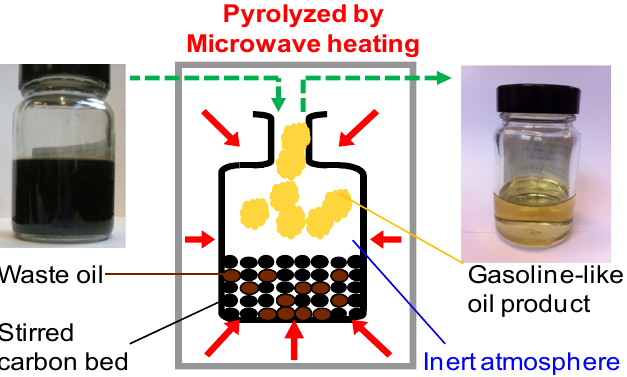
Figure 3. Schematic representation of the generation of gasoline-like oil product from microwave pyrolysis of waste oil